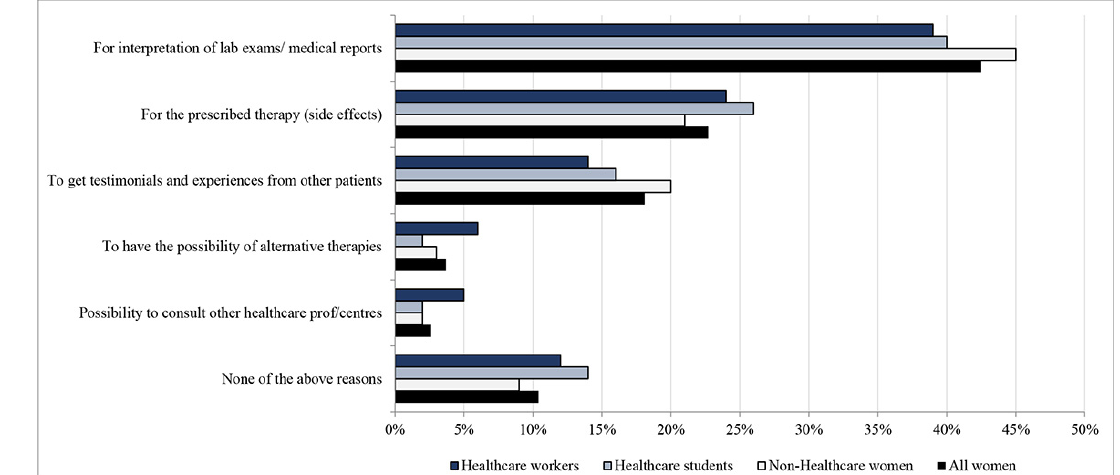
Figure 1 . Distribution of responses regarding the kind of information searched by women using Internet to get a second opinion after medical examination ( N = 3674).